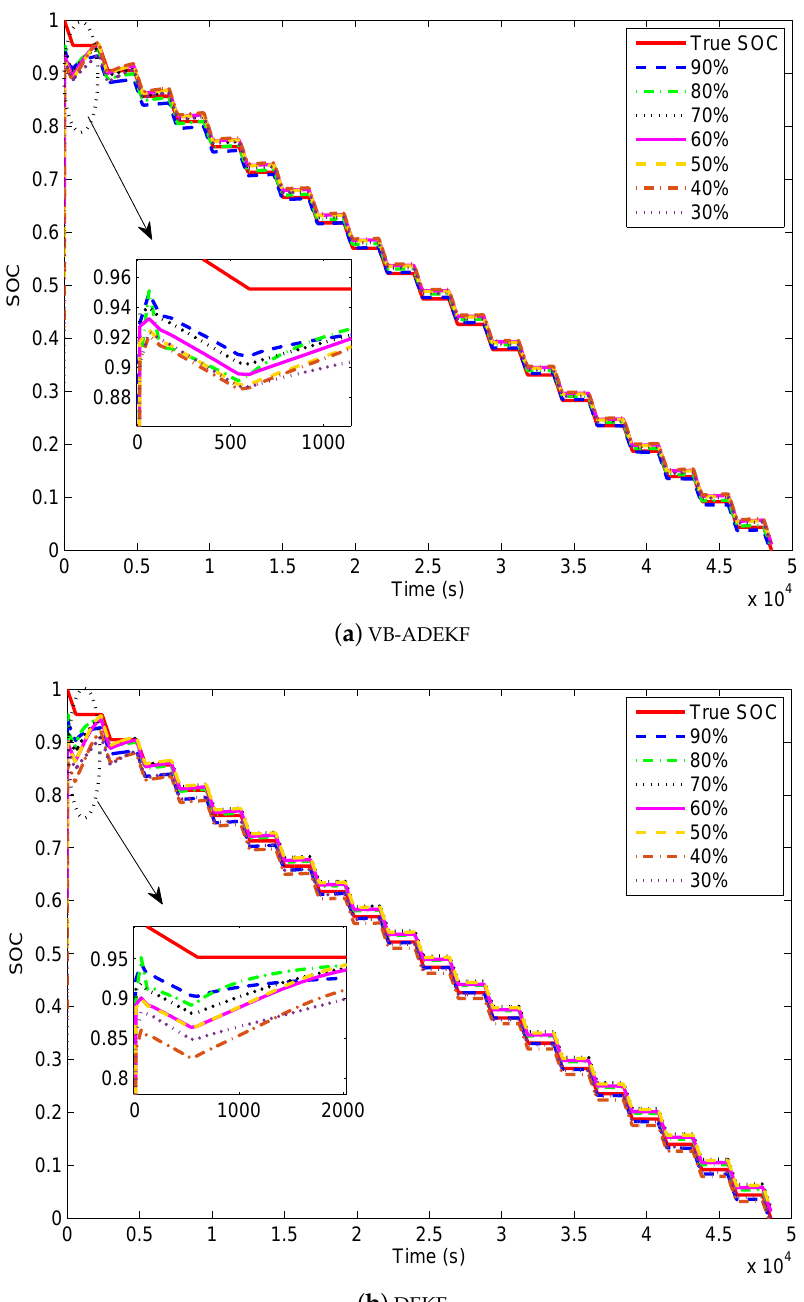
Figure 15. SOC estimation results of the two filters with different initial SOC values in the pulse current discharge